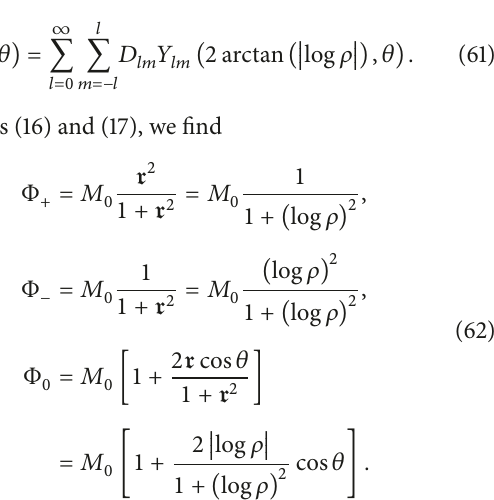
is an isometry from H to D . When uniformizing D ∗ to D